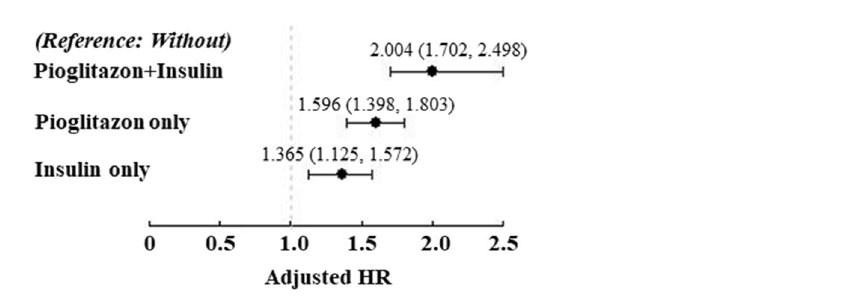
Figure 2. Cox regression analysis for risk of developing AD and T2DM patients receiving both insulin and